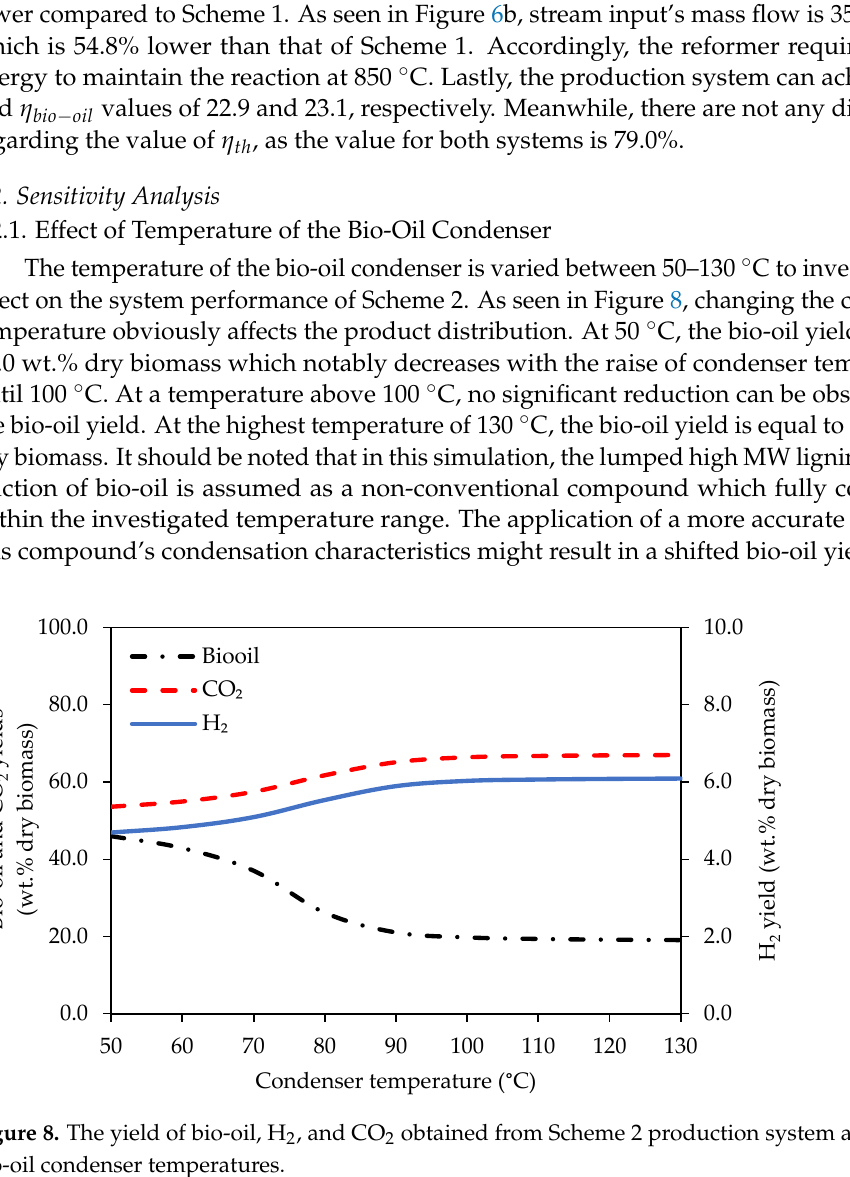
Table 7. Product yields and efficiencies of Scheme 1 and 2.